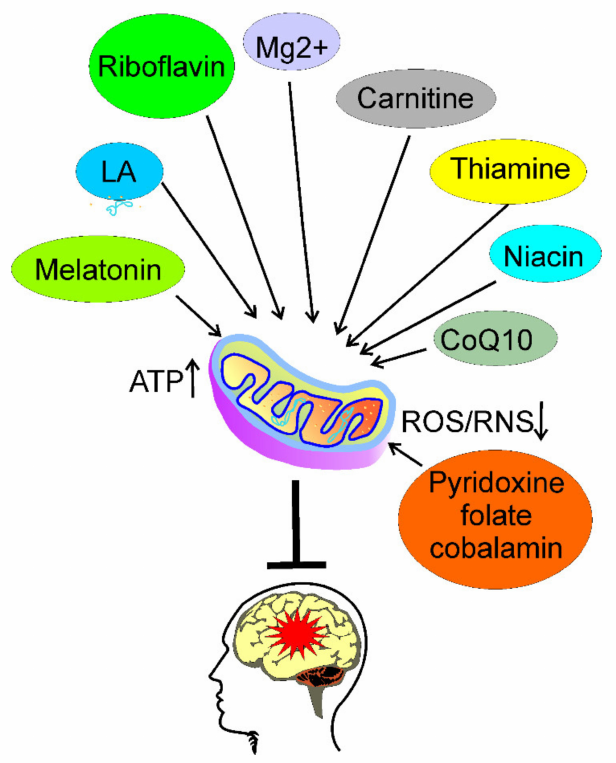
Figure 4. Some nutrients may prevent or cure migraine. Certain nutrients may improve energy production, and reduce energy deficit in the brain through improvement of mitochondrial functions, resulting in increased ATP production, and reduction of oxidative stress through decreasing reactive oxygen and nitrogen species (ROS and RNS, respectively). Such an action may prevent or ameliorate migraine (red star). Some candidates for such compounds are: riboflavin; thiamine; magnesium ions (Mg2+); niacin; carnitine; coenzyme Q10 CoQ10); melatonin; lipoic acid (LA); pyridoxine; folate; and